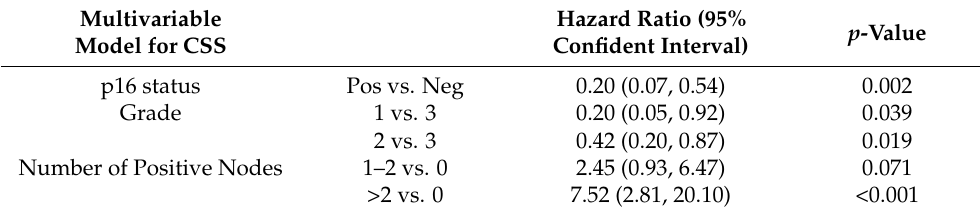
Table 5. Multivariable Model for CSS. p16 status is statistically significant in